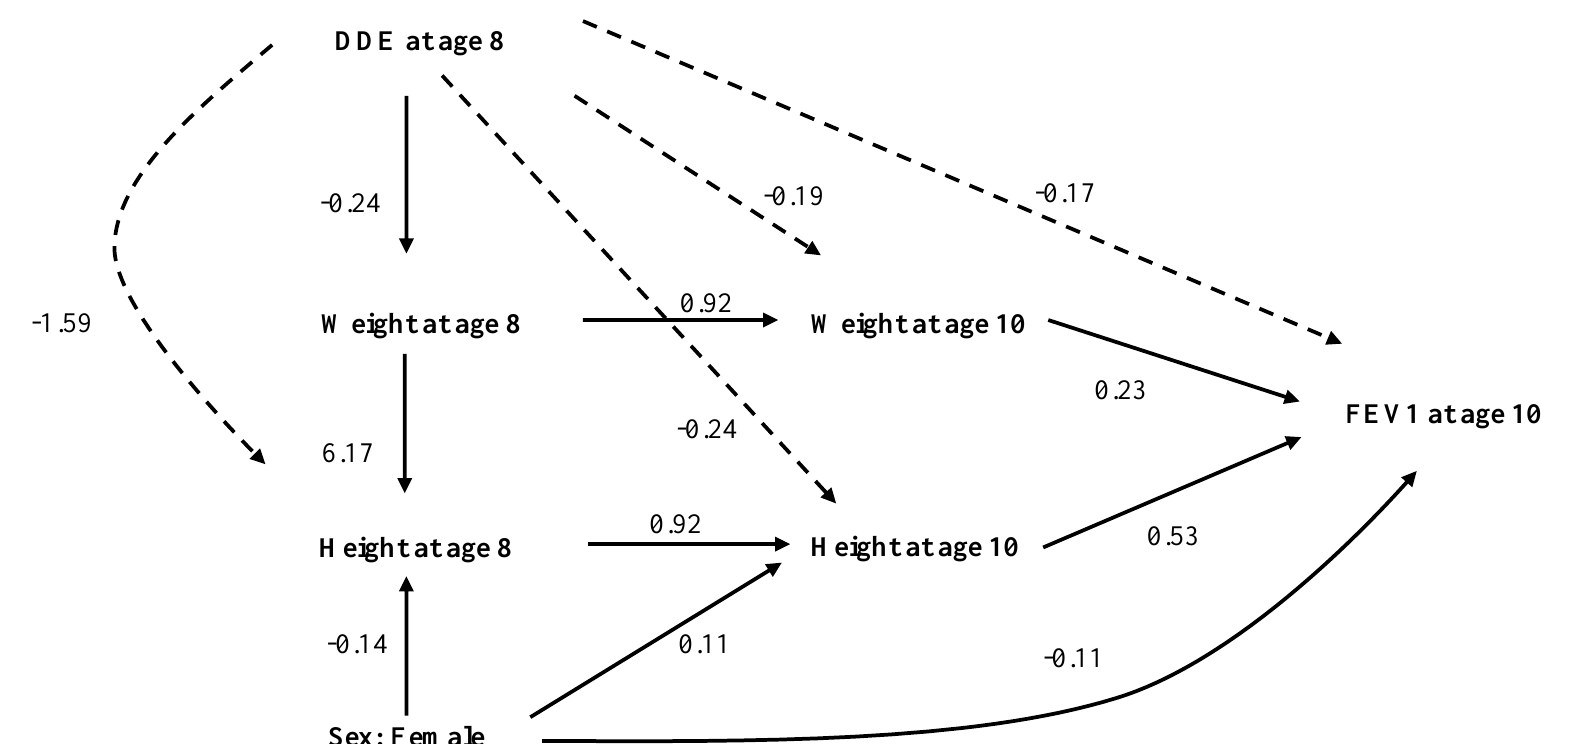
Figure 2. Analytical path model showing statistically significant, standardized, direct, and indirect effects of DDE exposure at eight years of age, height and weight at eight and ten years of age, and FEV1 at age 10 years. The path coefficients represented by solid arrows are direct effects, while those represented by dashed arrows are indirect effects. Associations with non-significant total effects are not shown in this diagram. Goodness of Fit Criteria: χ-squared test statistic = 33.7, p-value < 0.05; AGFI = 0.909; CFI = 0.994; RMSEA = 0.043.